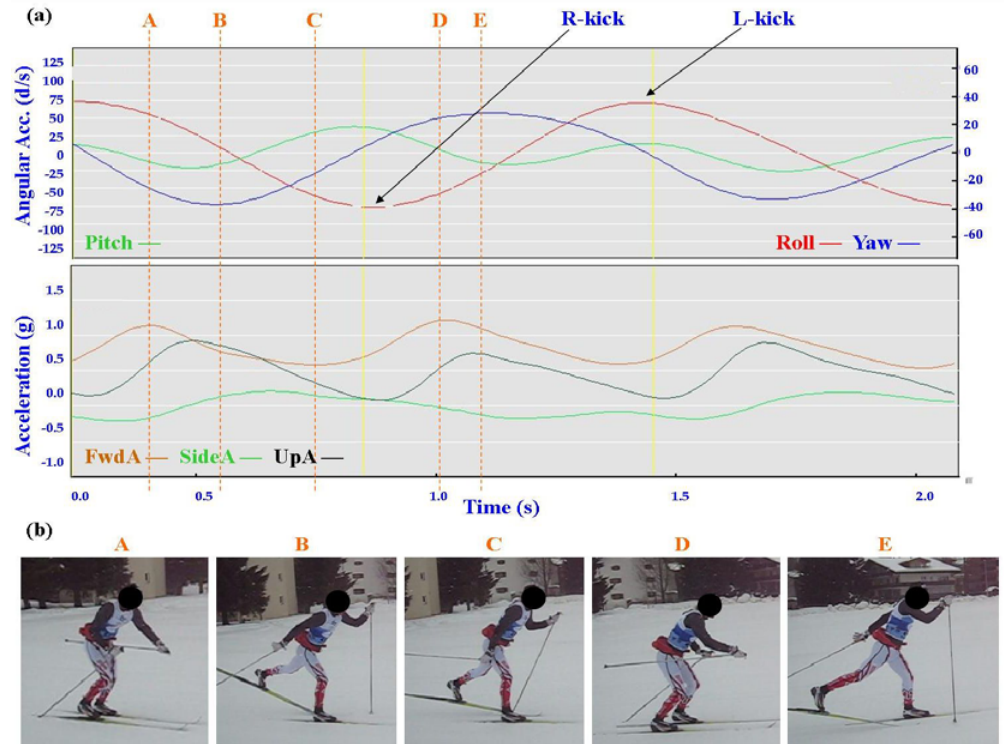
Figure 5. ( a ) Screenshot of Diagonal Stride (DS) gyroscope and accelerometer traces against time; ( b ) DS body position for selection